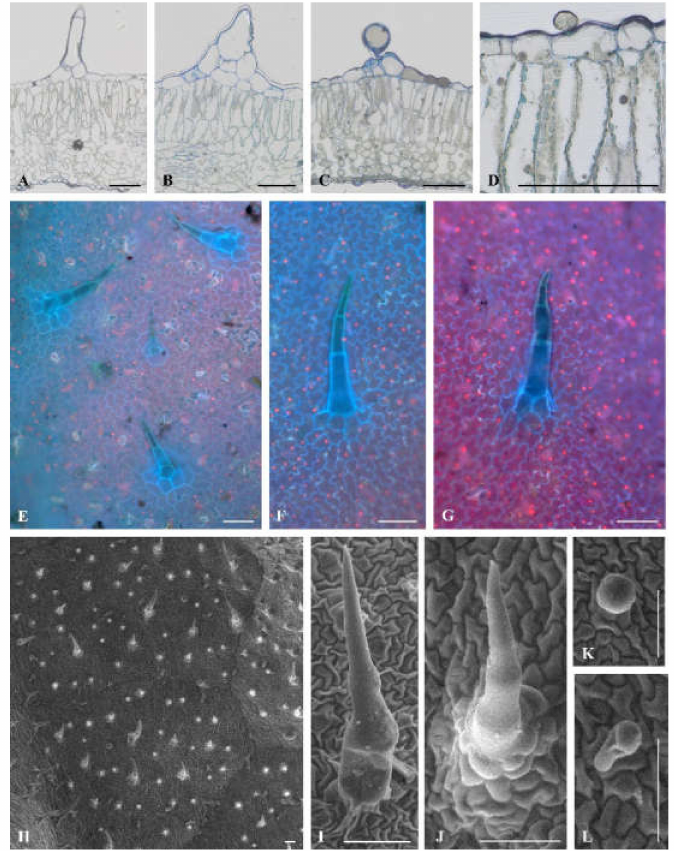
Figure 4. Trichome types on the Rudawa adaxial leaf surface. Light microscopy views of leaf cross-sections ( A − D ). Adaxial leaf surface at epifluorescence ( E ) and SEM ( H ), and trichomes ( F and G ) and ( H − L ), respectively. Non-glandular types: group II: B , G , J , group V: A , F , I , glandular types: group VII C and L , group VI D and K . All scale bars represent 100 µ